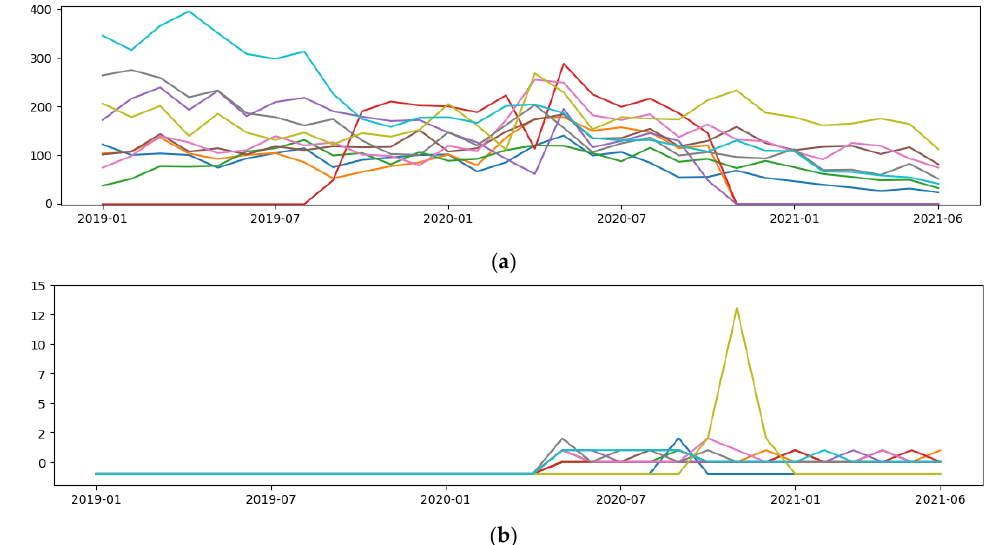
Figure 1. Sales of restaurants from January 2019 to June 2021. Each line represents one restaurant. The x -axis represents months, and the y -axis represents the number of orders. ( a ) The top ten restaurants with the greatest number of orders. ( b ) The ten restaurants with the least number of orders.